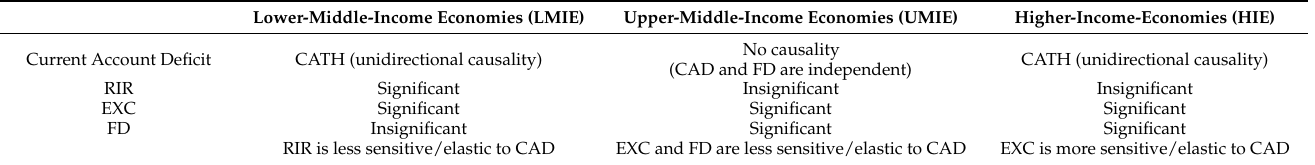
Table 18. Comparison between ASEAN-10, LMIE, UMIE, and